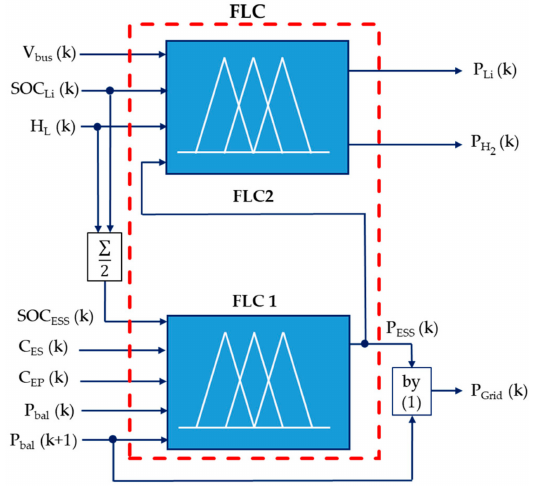
Figure 4. Fuzzy logic-based EMS control